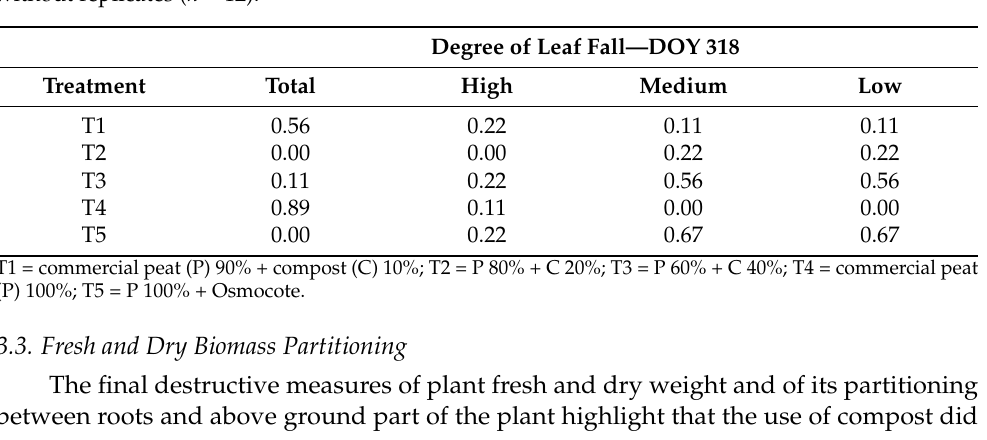
Table 6. Qualitative data about the percent of plant at different levels of defoliation in the compared theses in mid-November. DOY = day of year. Data are reported considering the total plant and without replicates ( n =